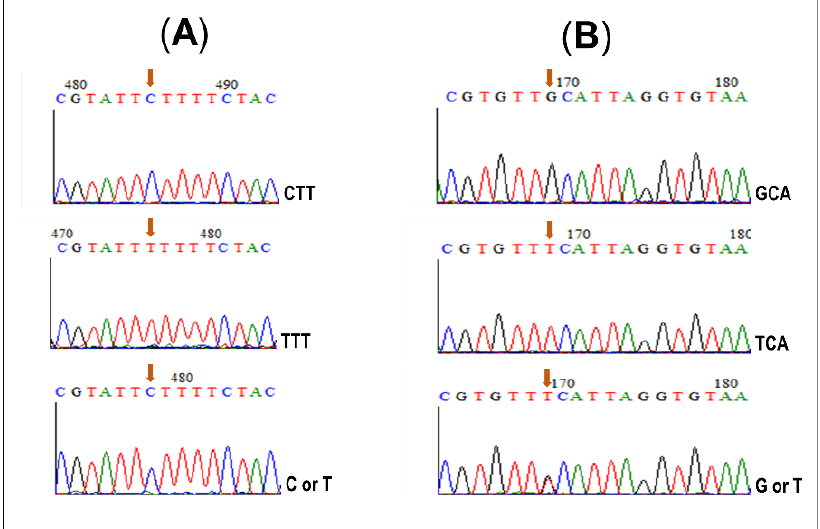
Figure 4. Sequence chromatograms of a 729 bp fragment in GSTe2 gene ( A ) and a 1006 bp fragment of the GABA-receptor gene ( B ); for susceptible (top), homozygote-resistant (middle) and heterozygote (bottom) An. funestus s.s. The polymorphic site is indicated by the red arrow.